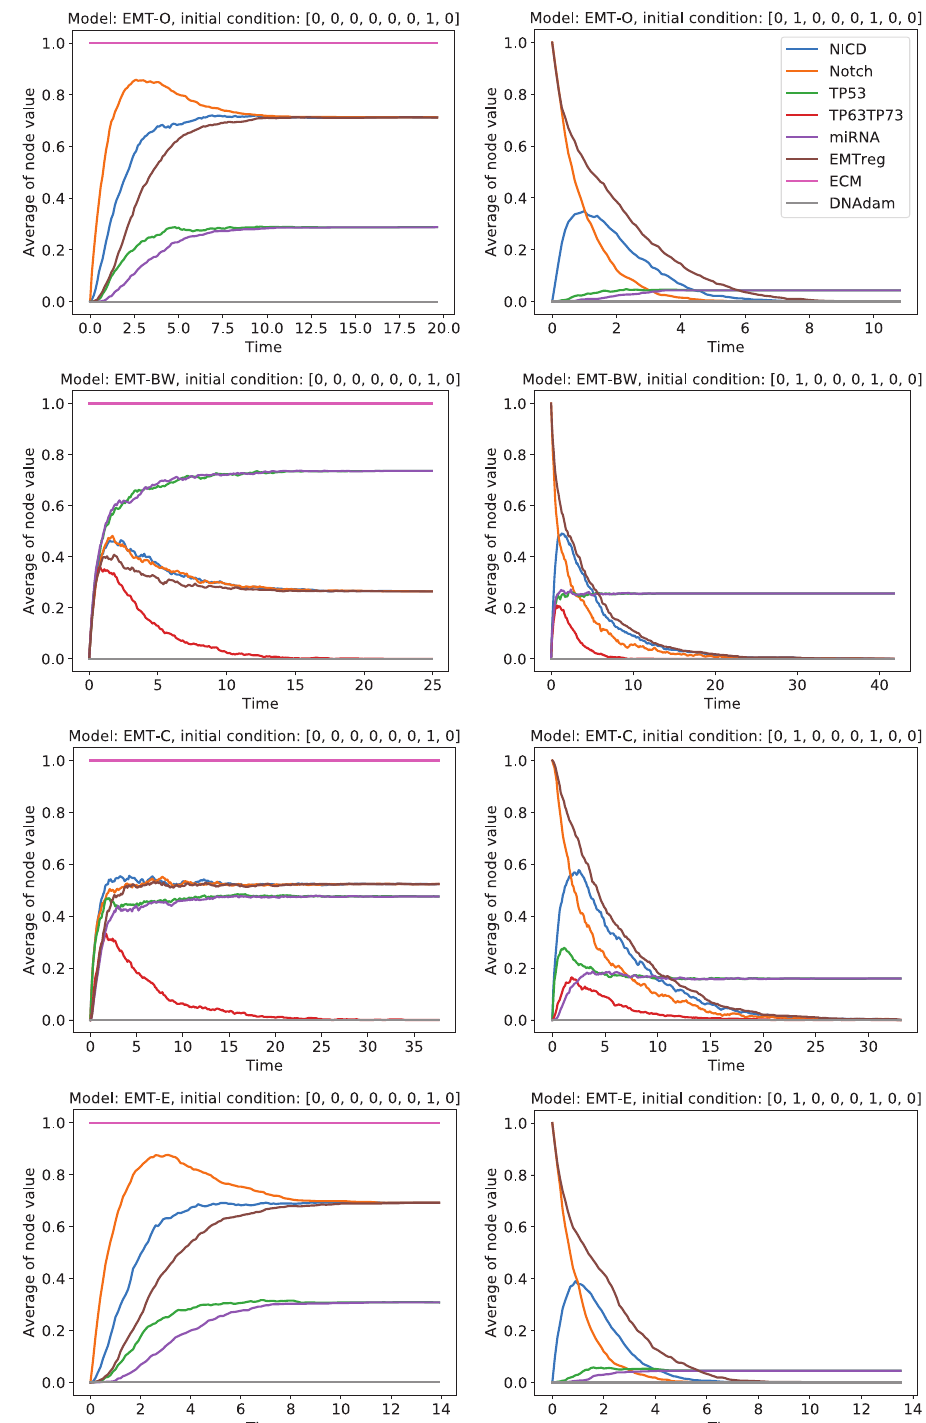
Fig 4. Comparison between EMT-O and some of our automatically created rulesets (EMT-BW, EMT-C, EMT-E). Initial state (0, 0, 0, 0, 0, 0, 1, 0) has the two attractors (0, 0, 1, 0, 1, 0, 0, 0) and (1, 1, 0, 0, 0, 1, 1, 0) (left column). The initial state (0, 1, 0, 0, 0, 1, 0, 0) converges towards the two attractors (0, 0, 1, 0, 1, 0, 0, 0) and (0, 0, 0, 0, 0, 0, 0, 0) (right column). On top, we depict the dynamics of the original model EMT-O. From row 2 to row 3 and 4, we include the more and more sophisticated automatically created network (EMT-BW, EMT-C, and EMT-E, respectively).